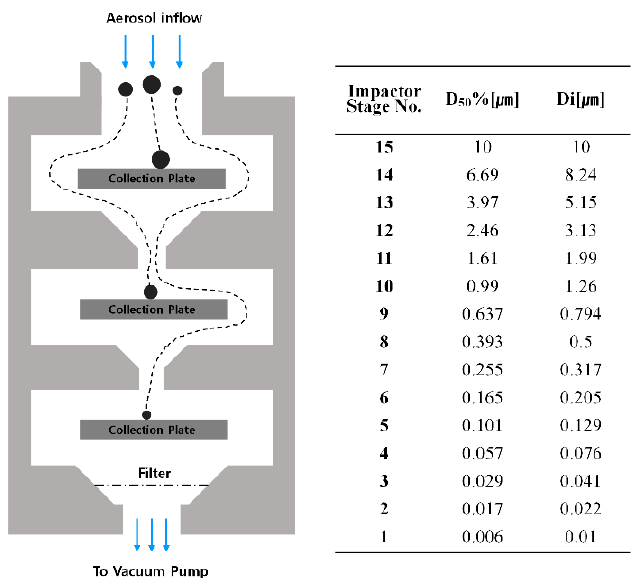
Figure 2. A schematic of the cascade impactor and cut-off diameters of each stage in the ELPI cascade impactor.